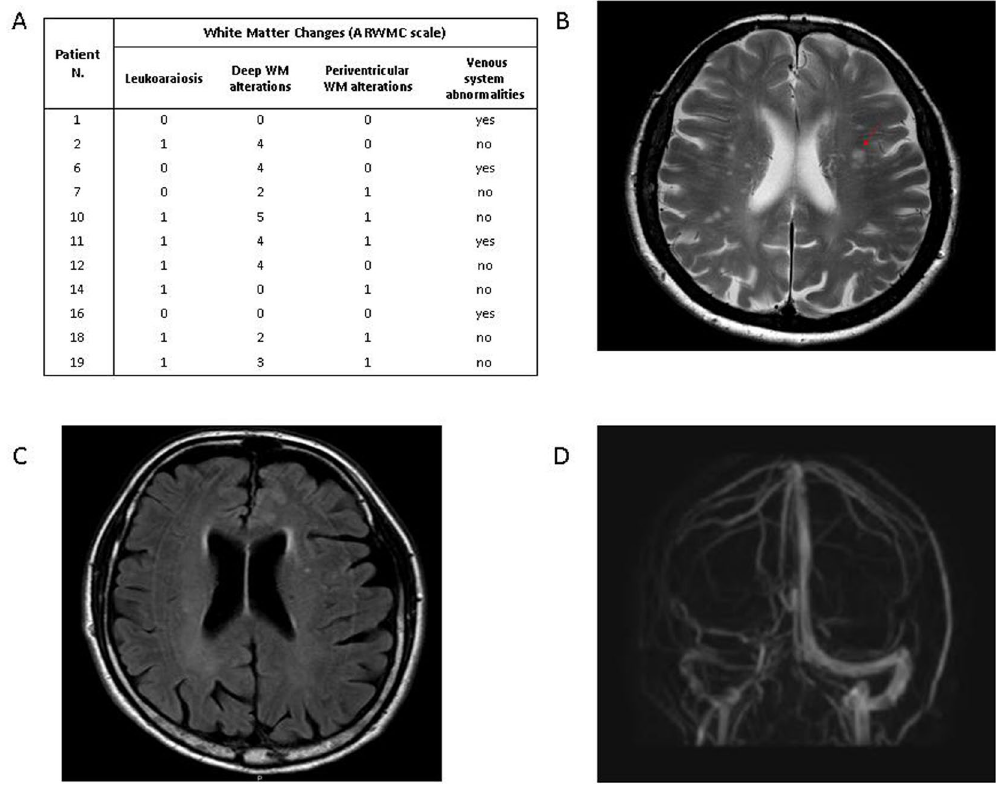
Figure 1. Pathological brain MRI findings in PNH patients. ( A ) White Matter Changes (ARWMC scale, see Materials and Methods) ( B ). The T2 weighted axial image shows several t2 focal hyperintensities of WM due to chronic microinfarcts (patient N.10); ( C ) The FLAIR axial image shows periventricular hyperintensity due to vascular chronic degeneration (patient N. 7); ( D ) The Phase Contrast acquisition shows the asymmetry of venous sinuses with irregular walls of the right transverse sinus that can be due to a previously occurred venous thrombosis (patient N. 1). Control population (n = 38) findings: 9 leukoaraiosis, 19 deep WM focal chronic ischemic lesions (n = 5, score 1; n = 10, score 2; n = 3, score 3; n = 1, score 4); a lesion > 5mm was observed in 2 subjects aged 53 and 83